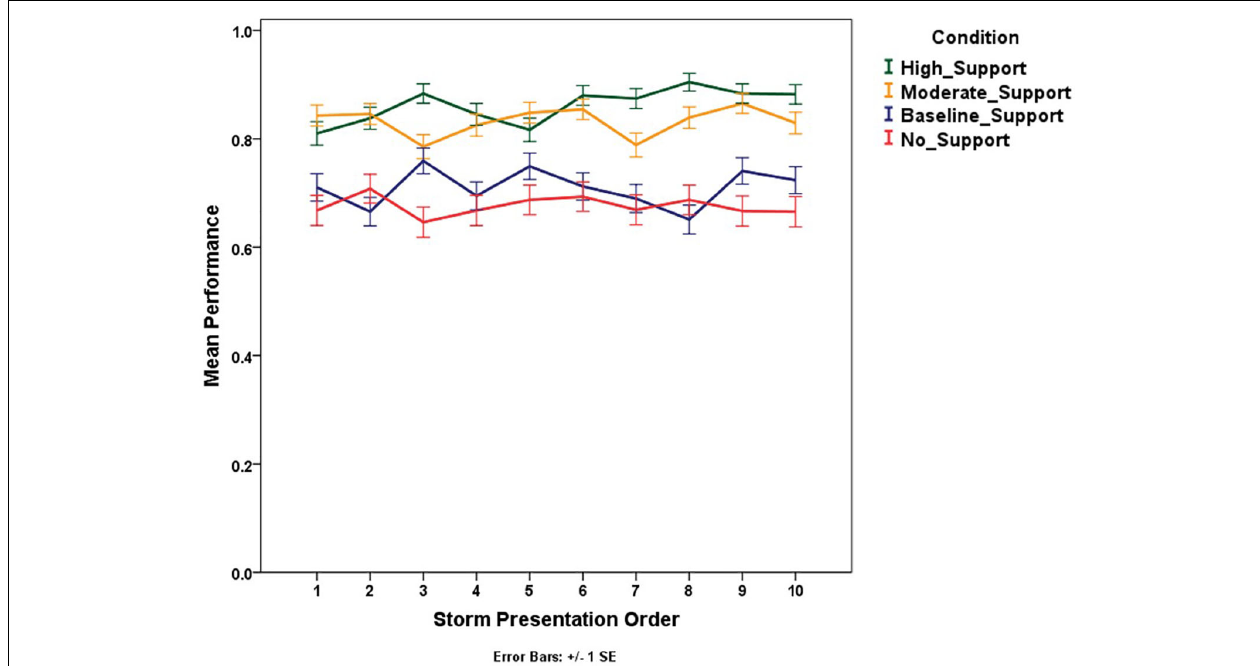
FIGURE 11 | Mean performance (proportion correct) trend for subsequent storms presented across conditions.